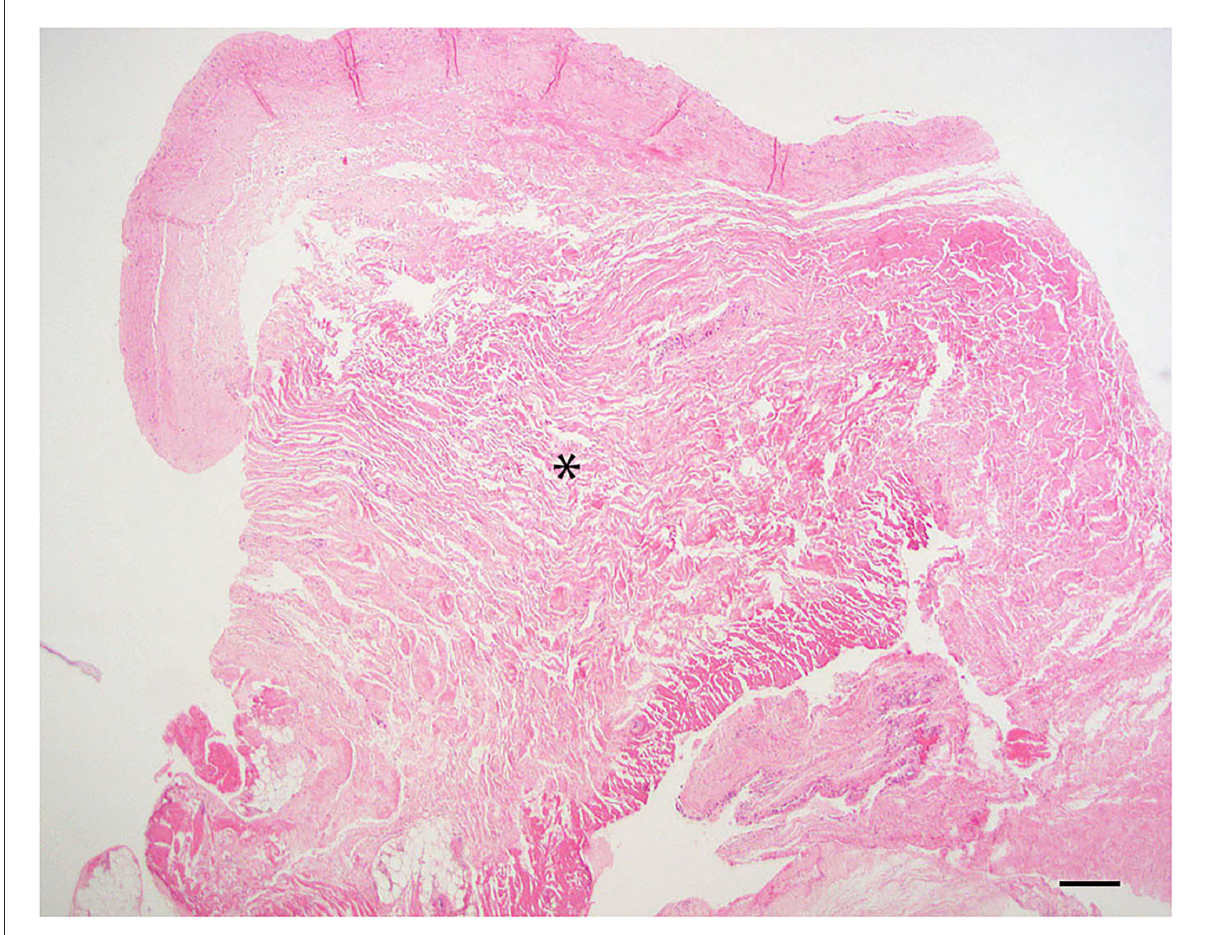
FIGURE3 Dural fibrosis; 20 × –Scale bar = 50 microns; Asterisk indicates area of